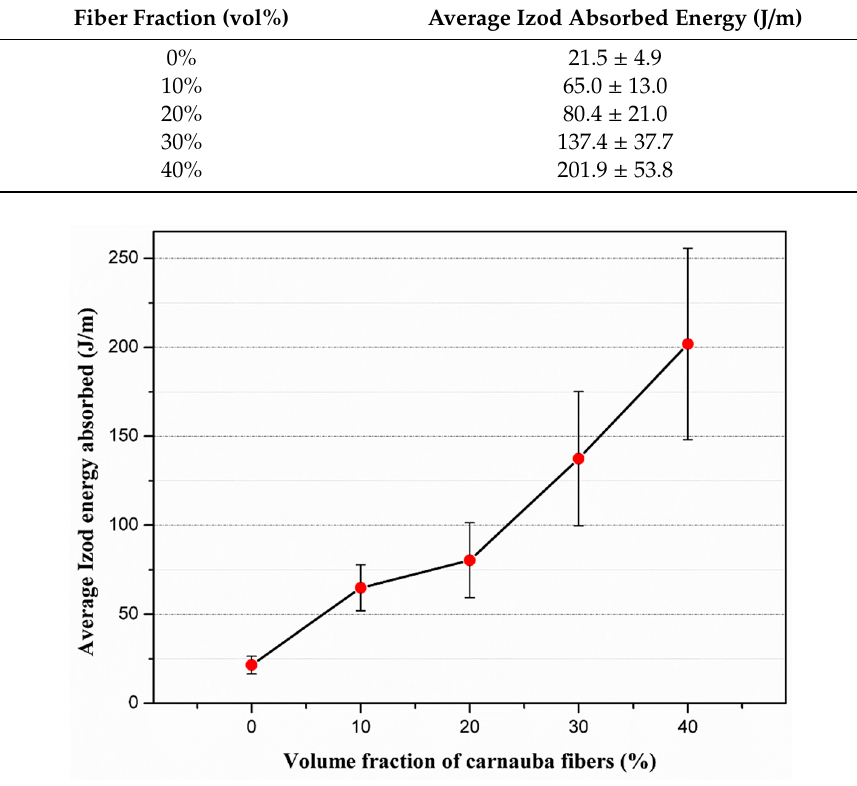
Figure 9. Izod impact energy as a function of the fiber fraction for the neat epoxy resin and carnauba fibers reinforced composites.